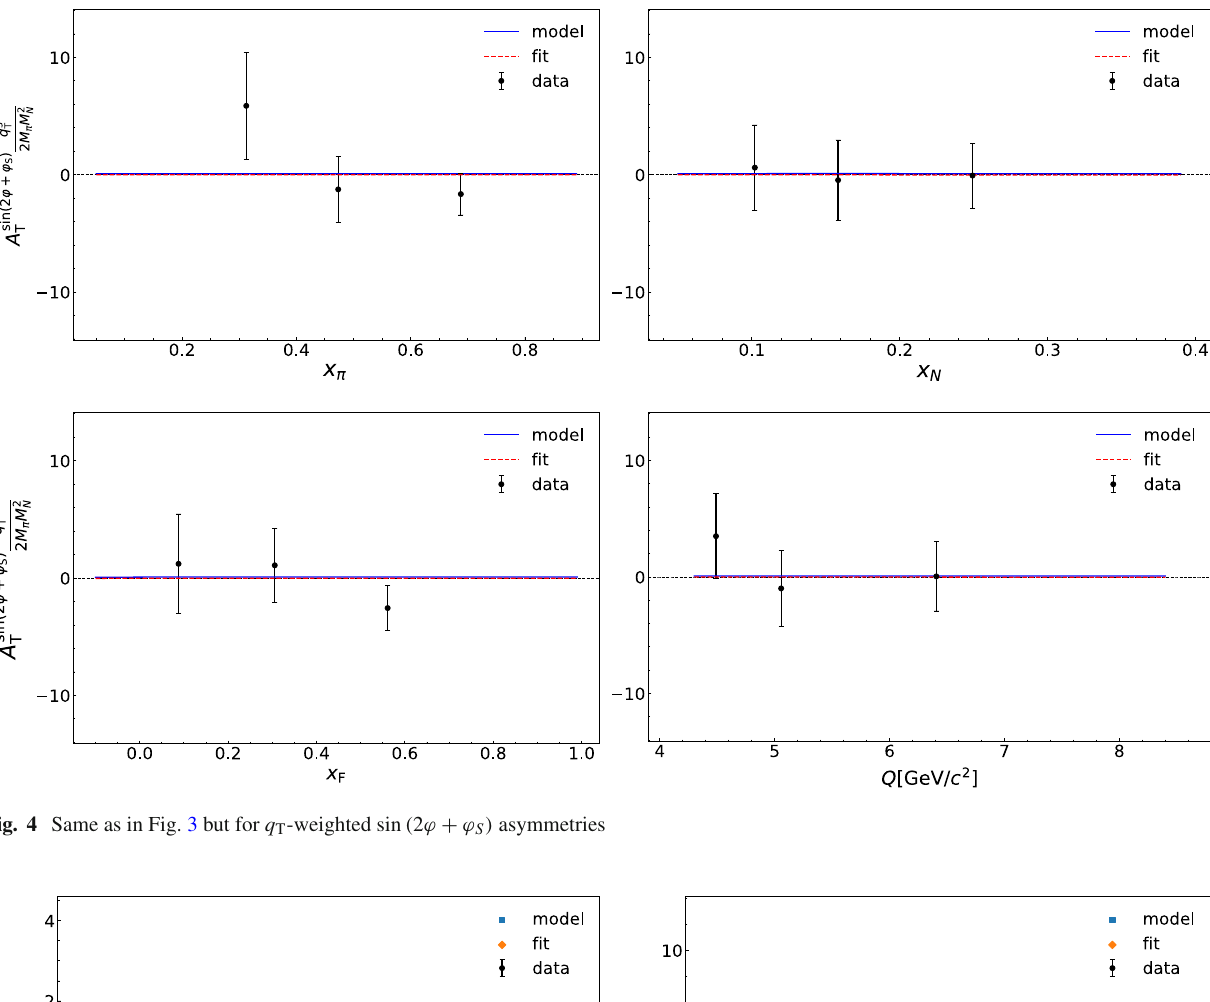
Fig. 4 Same as in Fig. 3 but for q T -weighted sin ( 2 ϕ + ϕ S ) asymmetries